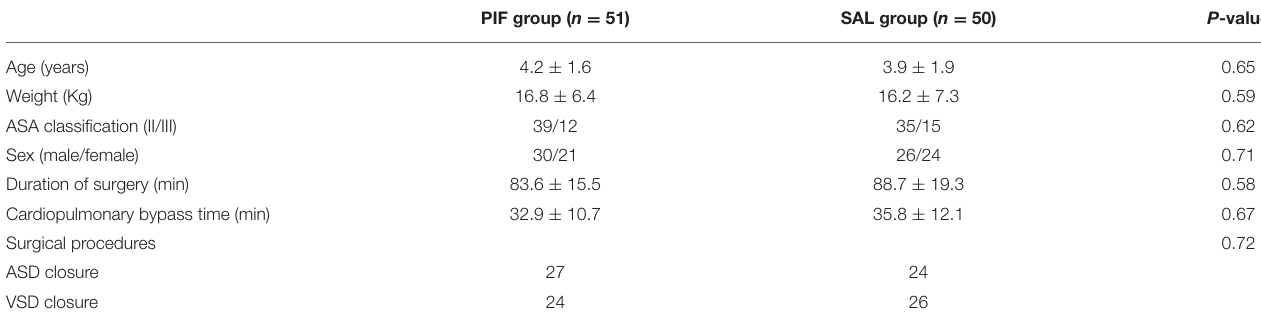
TABLE 1 | Demographic data and surgical